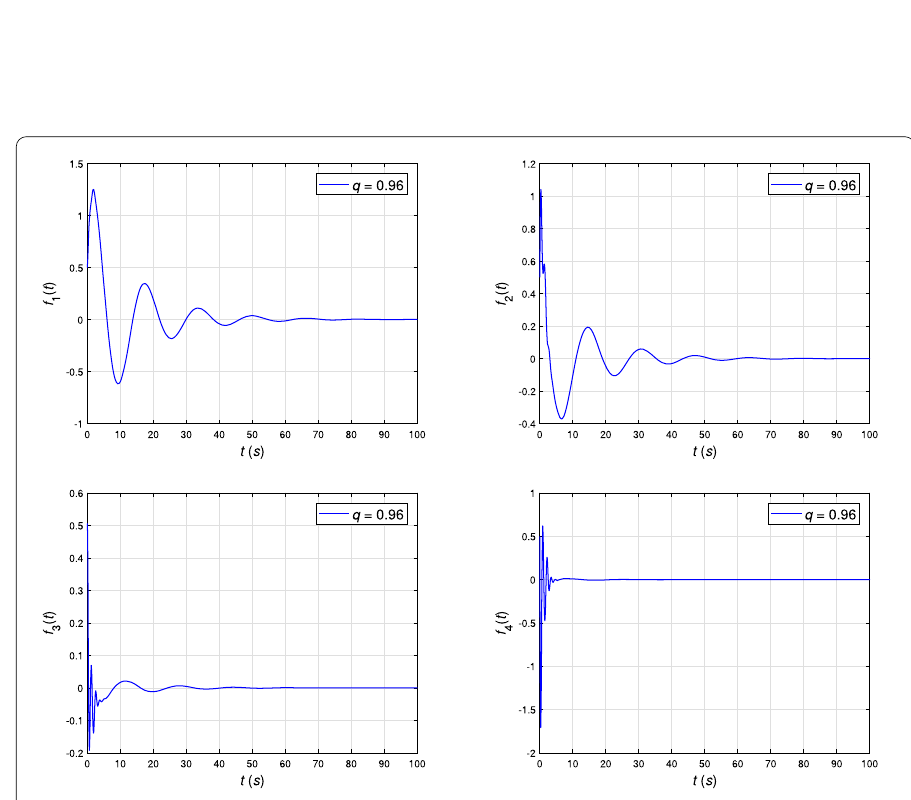
Figure 10 The time-domain responses of the controlled system (14) for q =